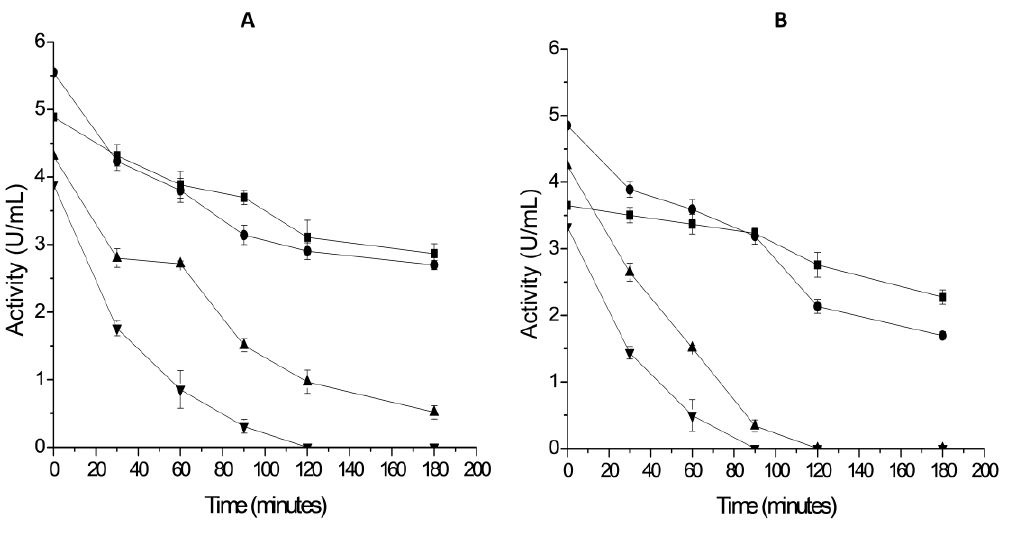
Figure 5. Thermal stability of pure lipases ( A ) Lip1 ( B ) Lip2. pH symbols: - ■ - 30 °C; -●- 40 °C; - ▲ - 50 °C; - ▼ - 60 °C.